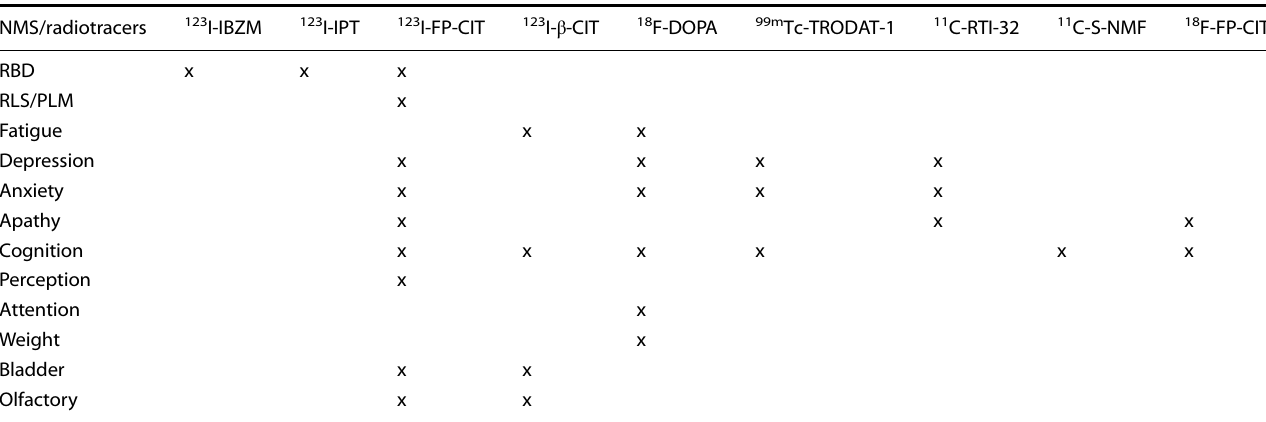
Table 8. Radiotracers used to assess dopaminergic NMS pathophysiology in PD NMS/radiotracers